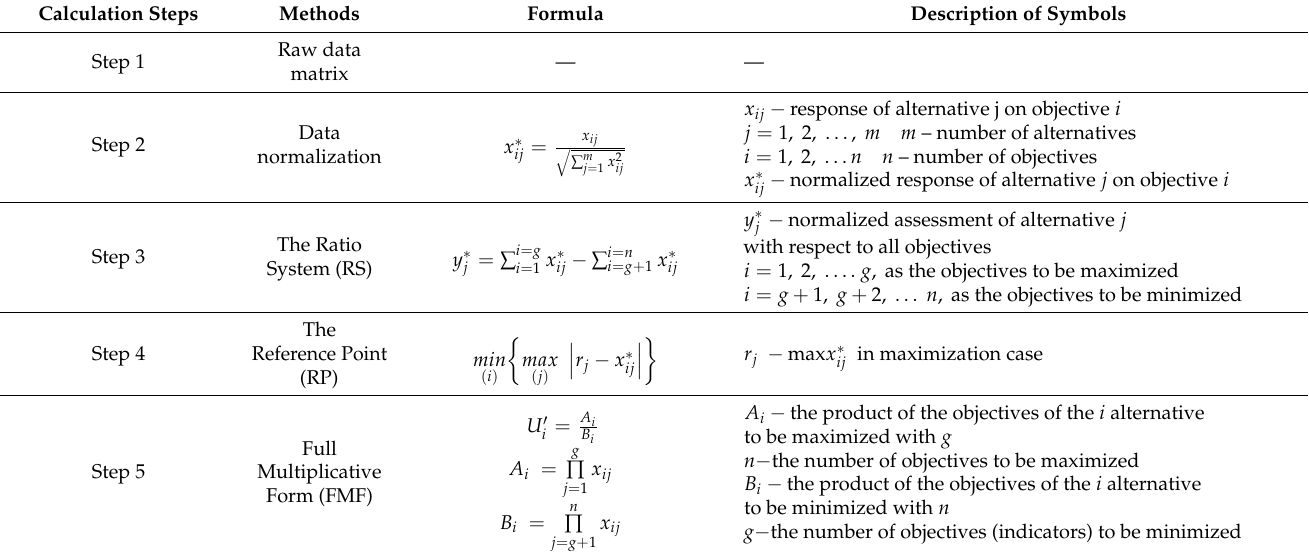
Table 1. The Multi-Objective Optimization by Ratio Analysis with the Full Multiplicative Form of Multiple Objectives (MULTIMOORA)